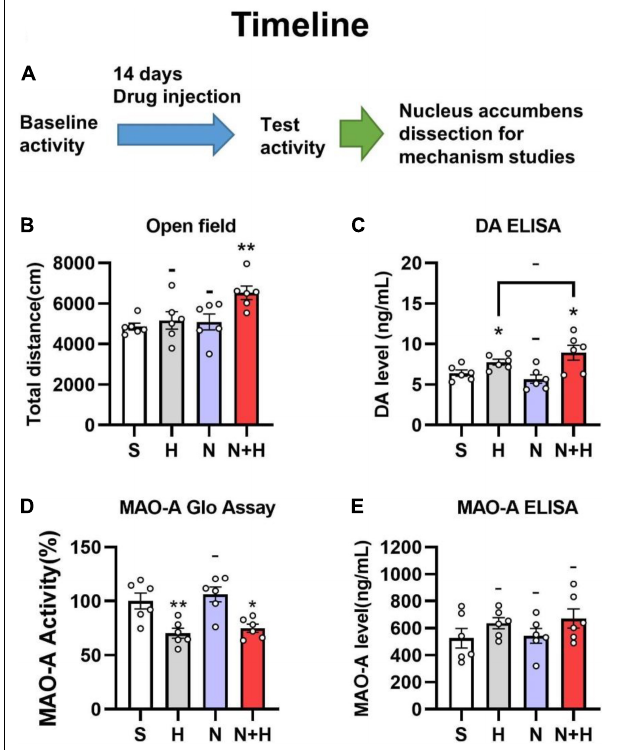
FIGURE 3 | (A) Timeline of subcutaneous administration in rats. (B) Effects of nicotine and harmane on the open field total distance of the rats in S, H, N, and N + H groups after drug injection. Rats in the N + H group significantly increased the open field total distance (** p < 0.01), while no significant difference were found in the other groups. (C) Effects of nicotine and harmane on the basal level of dopamine in the nucleus accumbens. Compared to the S group, the dopamine level in the H and N + H groups increased significantly (* p < 0.05), but there was no significant change in the N group. (D) Effects of nicotine and harmane on the activity of MAO-A in the nucleus accumbens (NAc) of rats. Compared to the S group, the MAO-A activity in the H and N + H groups decreased significantly (* p < 0.05), but there was no significant change in the N group. (E) Effects of nicotine and harmane on levels of MAO-A in the nucleus accumbens (NAc) of rats. No significant difference was found in the all four groups. Data are presented in the figure using mean ±